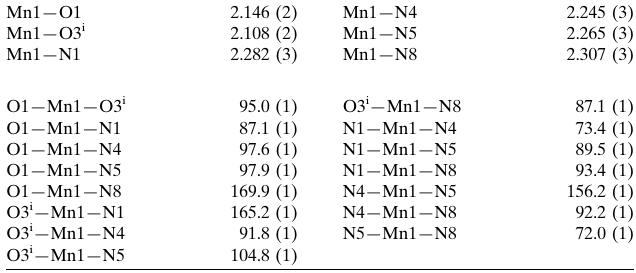
Selected geometric parameters (A˚ , (cid:2)